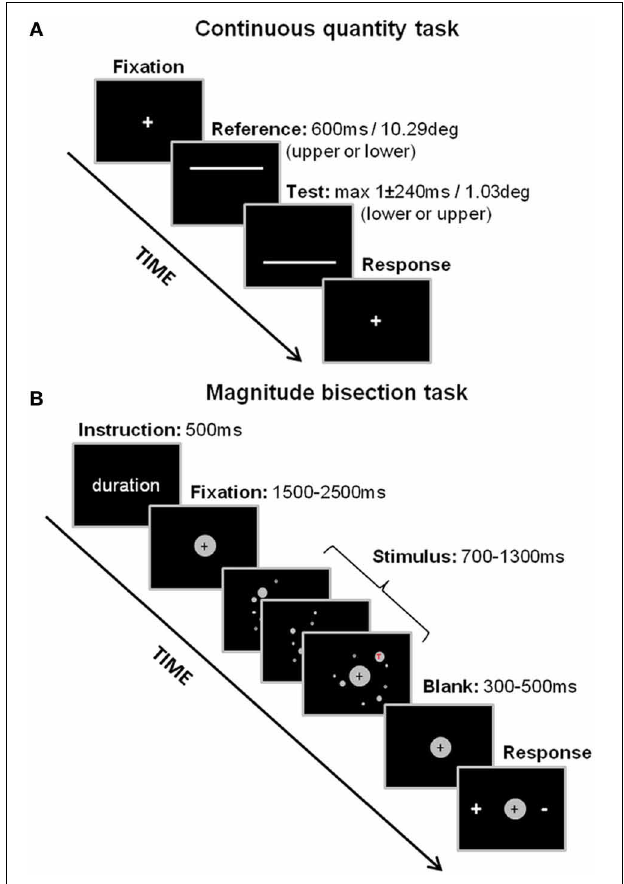
FIGURE 1 | Experimental designs for the continuous quantity tasks (A) and the magnitude bisection tasks (B). In the continuous quantity tasks, participants had to compare the length or the duration of two lines presented sequentially on the screen. In the magnitude bisection tasks, participants had to decide whether the number of dots, cumulative area covered by dots or duration of the display was closer to a small/short or a large/long